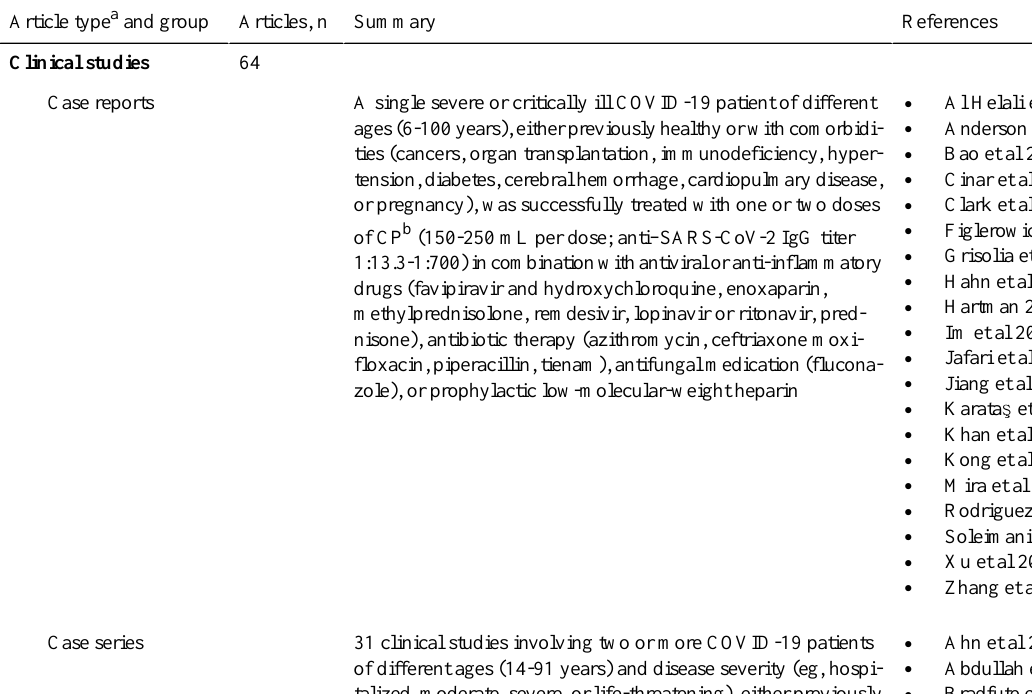
Table 1. Summary of literature.